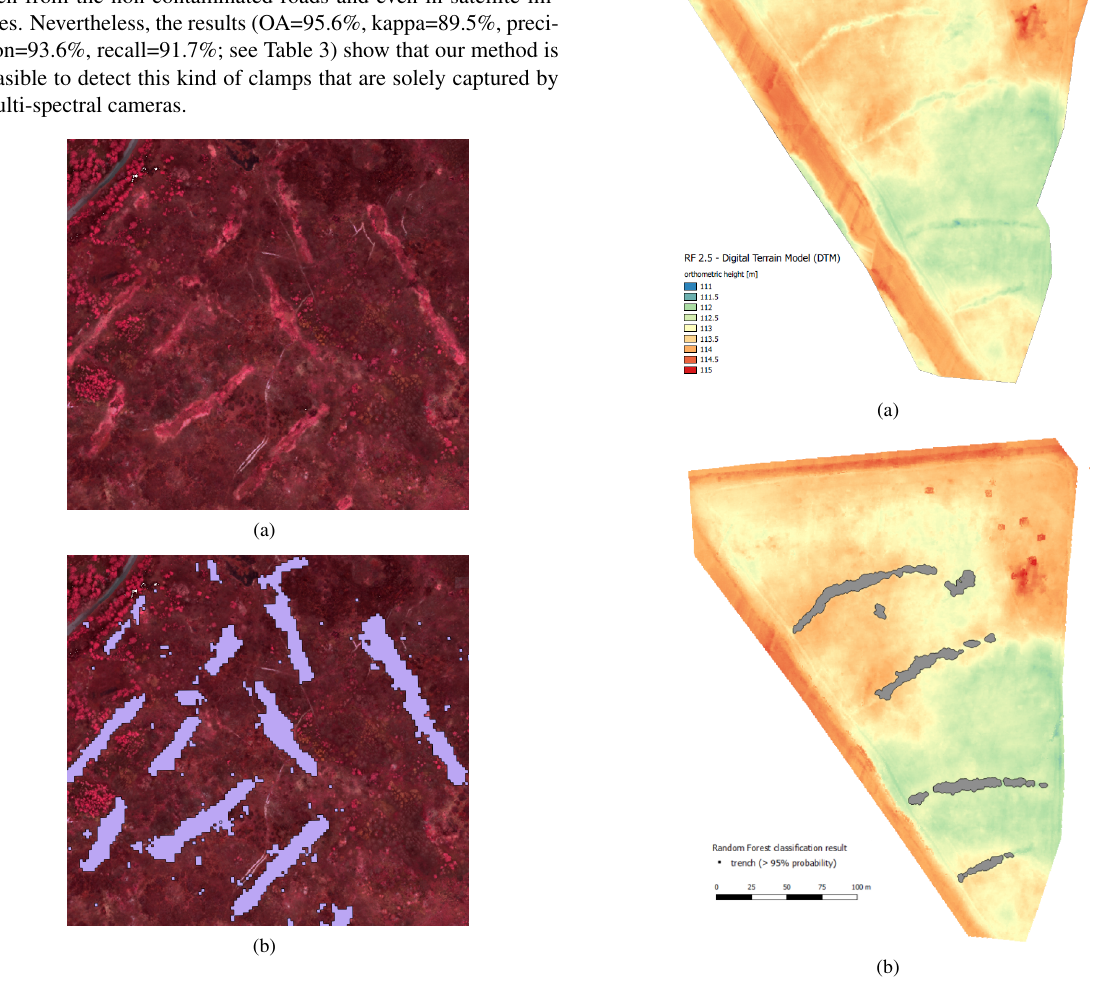
Figure 4. Study area 1: (a) Test area; (b) Classification result for class ”clamp”, class probability values > 95% Figure 5. Study area 2: (a) Filtered DTM; (b) Classification result for class ”trench”, class probability values > 95%